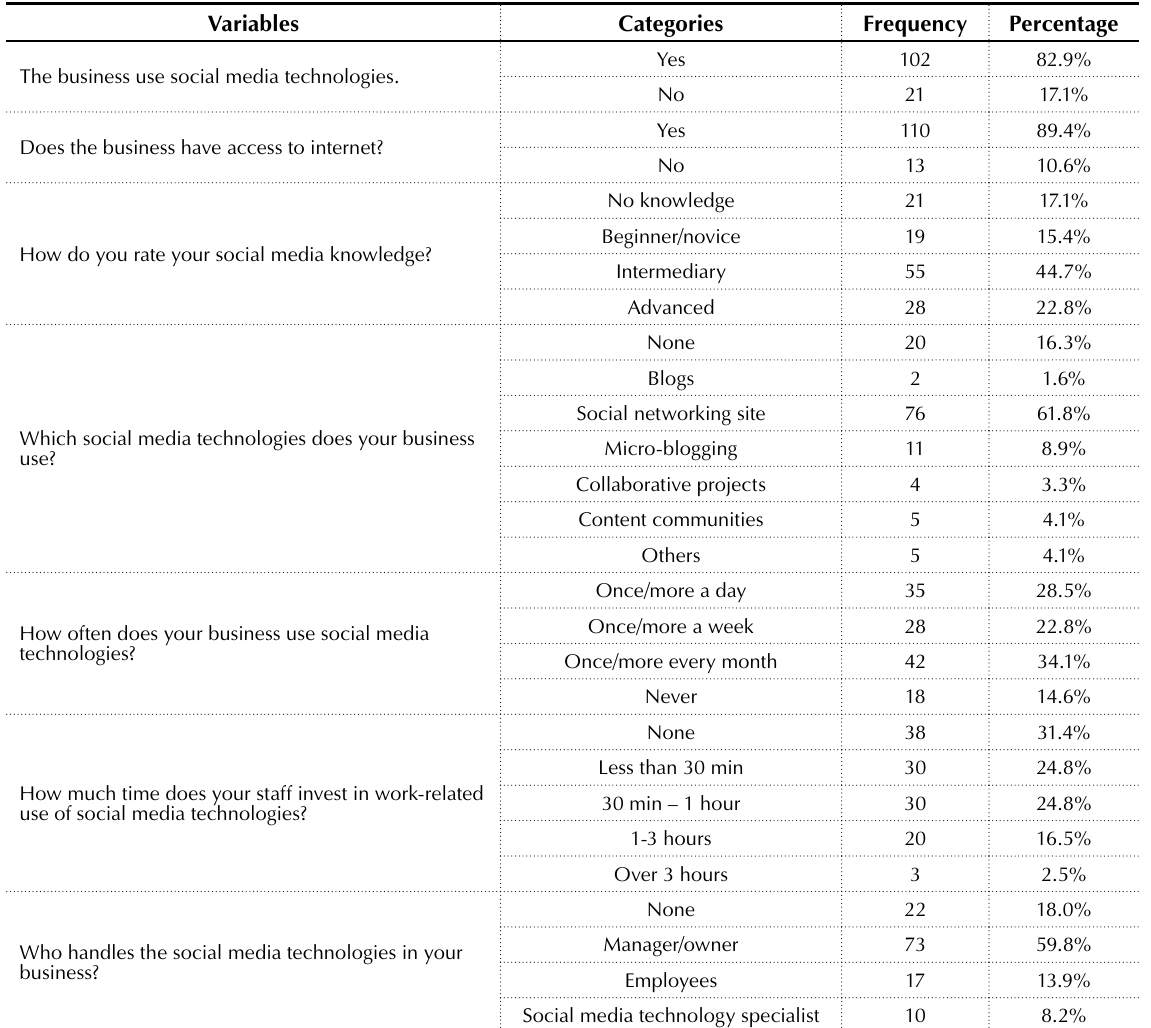
Table 3. Status and utilization of social media